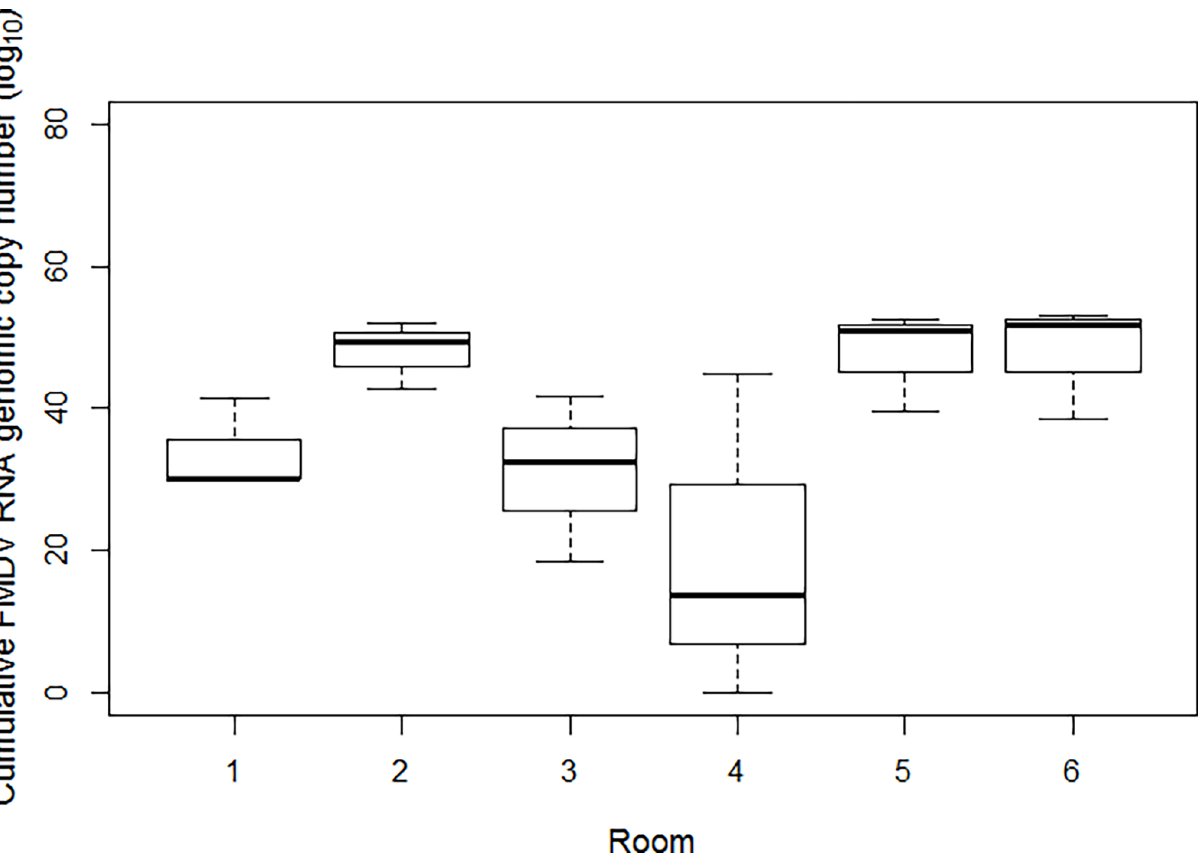
Fig 1. Box plot of accumulated viral RNA loads in NS and OS from the three donor sheep per room over the first 6 dpc.